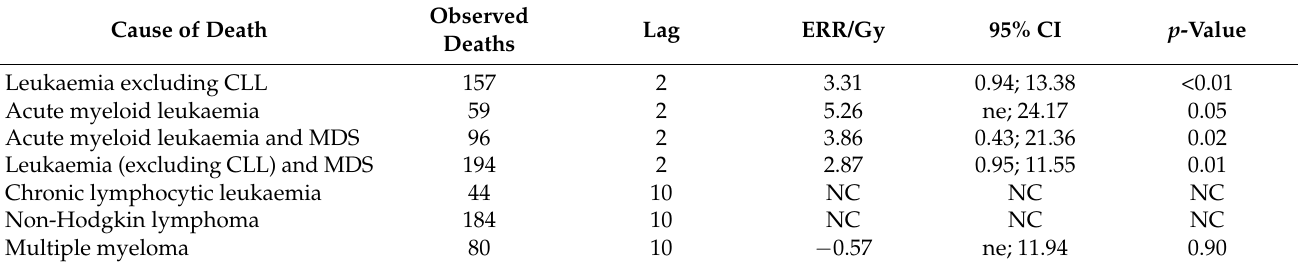
Table 3. Excess relative rates * of hematopoietic and lymphatic cancer death per Gray (ERR/Gy) of cumulative red bone marrow dose in males only, SELTINE cohort, period